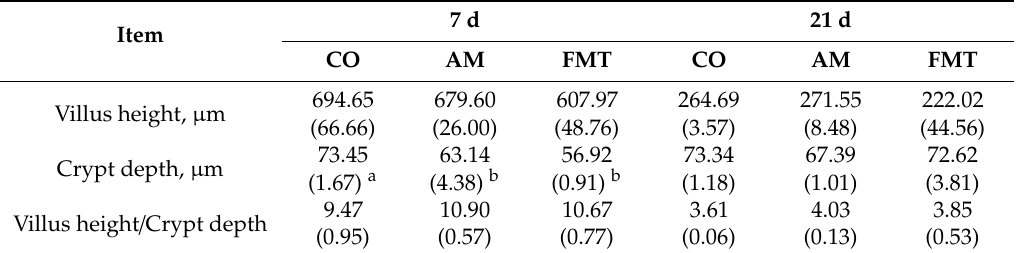
Table 1. Morphology analysis of ileum in neonatal pigs in the amoxicillin (AM), fecal microbiota transplantation (FMT), and control (CO) groups on days 7 and